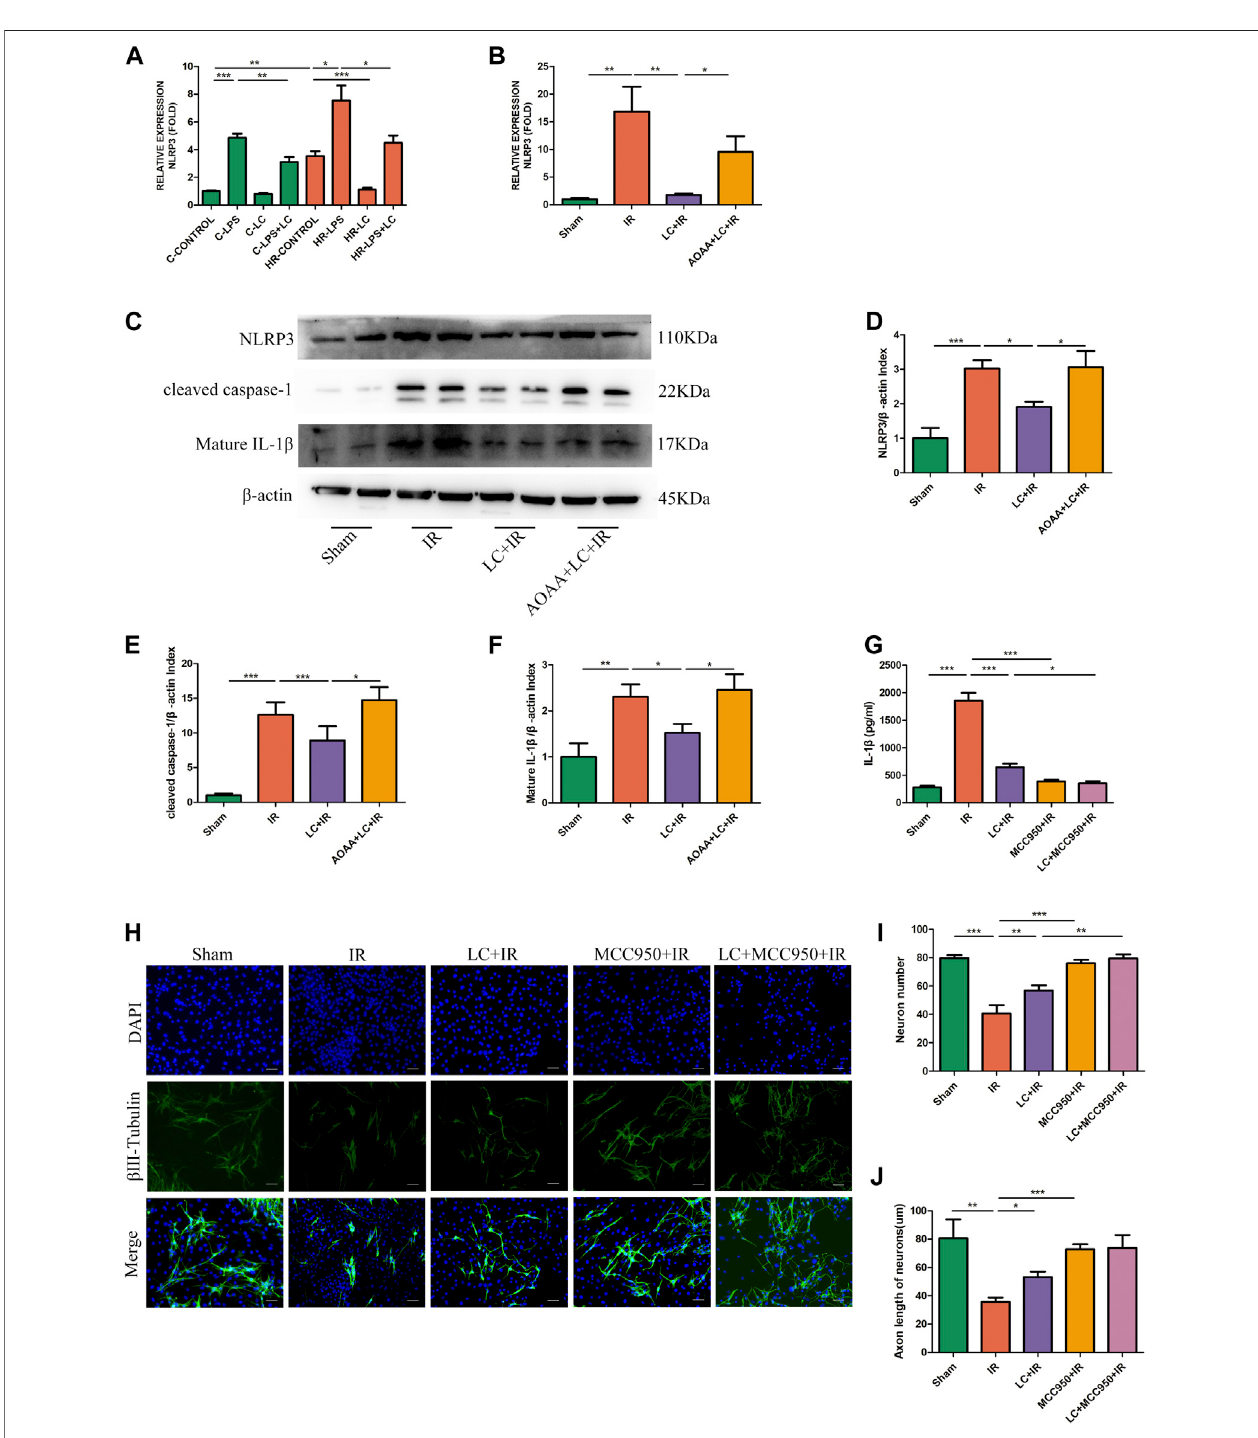
FIGURE 6 | L-Cys ameliorated myenteric neuron injury caused by IR through the NLRP3-IL-1 β pathway. (A,B) The mRNA levels of NLRP3 were detected under normal/Sham and HR/IR conditions by qRT-PCR. N = 4 /group. I Representative immunoblots were detected for NLRP3, cleaved caspase-1, and mature IL-1 β levels withWesternblotanalysisineachgroup. (D – F) QuantitativeanalysesoftherelativelevelsofNLRP3/ β -actin,cleavedcaspase-1/ β -actin,andmatureIL-1 β / β -actinineach group. N = 6 /group. Values were normalized to β -actin. (G) Protein levels of IL-1 β in LMMP were detected by ELISA. N = 4 /group. (H) After the IR model was performed, intestinal myenteric neurons were isolated and cultured for 6 days in vitro for immuno fl uorescence staining with representative images of β Ⅲ -tubulin (green) andDAPI(blue).Scalebar=50 μ m. N=4 /group. (I,J) Quantitativeanalysesofthenumberofneuronsandthelengthofaxons.Sixrandomlycapturedimagesperanimal were analyzed for each group. N = 4 /group. Values are mean ± SEM , * p < 0.05, ** p < 0.01, and *** p < 0.001 according to ANOVA with the Newman – Keuls test.